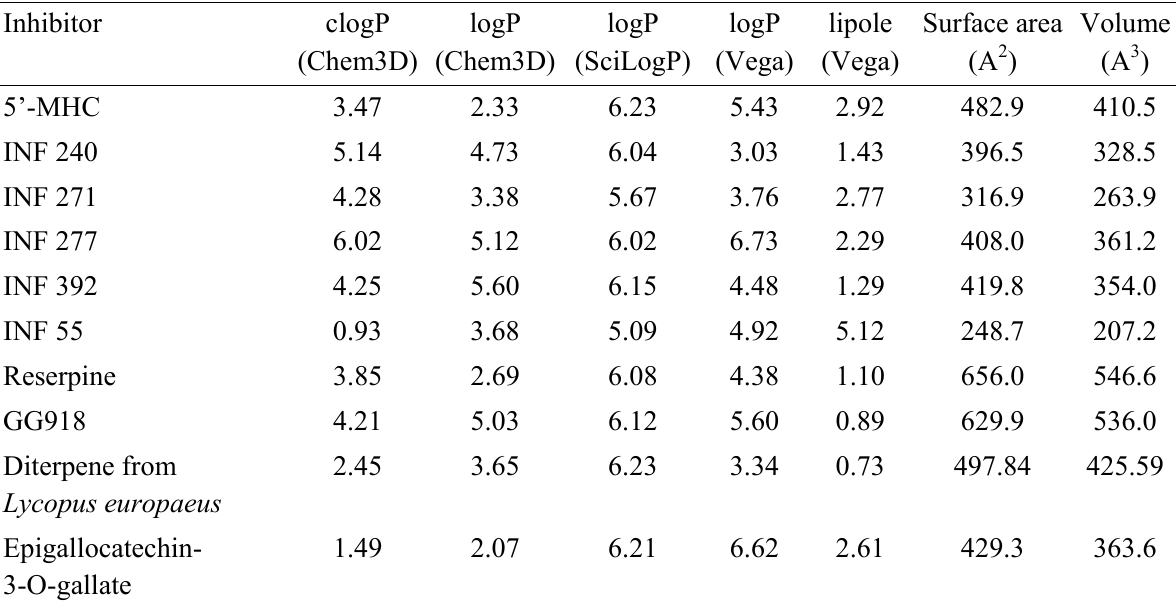
Table 3. Theoretically calculated values of clogP, logP, surface area and volume of all studied MDR inhibitors and non potentiators by different